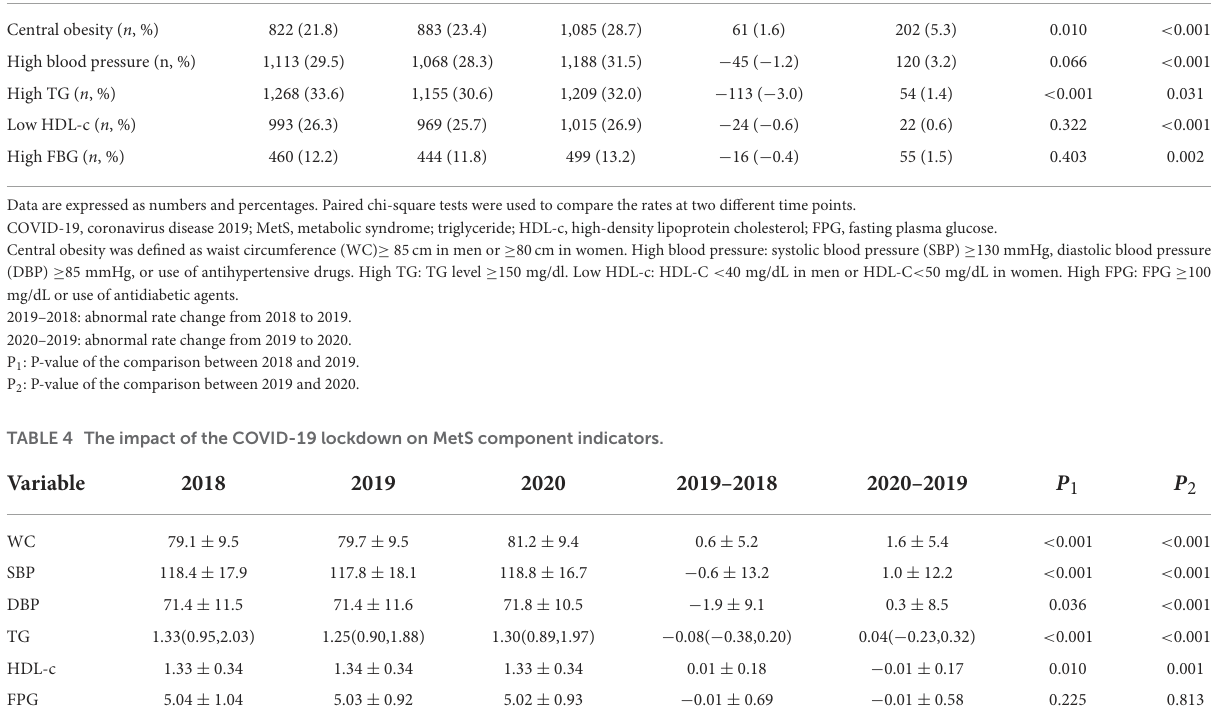
TABLE 3 The impact of the COVID-19 lockdown on abnormal rates of five MetS components. Variable